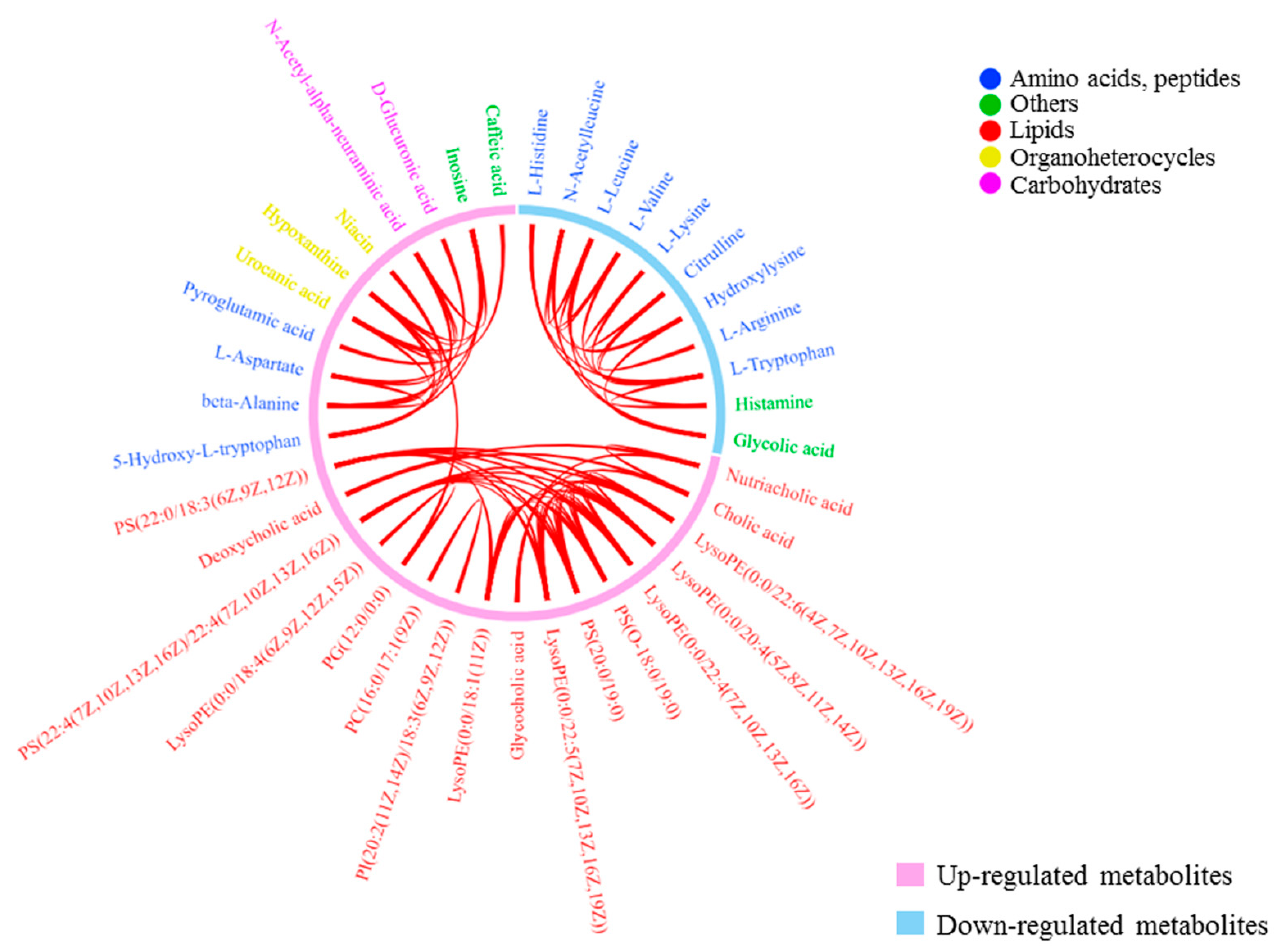
Figure 4. Chord diagram of the correlations between differential metabolites. When Pearson correla- tion coefficient between two metabolites is higher than 0.7 in absolute value, a connection is estab- lished. Colors denote the classification of metabolites. The pink circular arc represents up-regulated metabolites, and the blue circular arc represents down-regulated metabolites. More correlations between metabolites trend toward positive correlations. The most conspicuous correlations are lipid–lipid connections and amino acid-amino acid connections, revealing unique functional clusters of co-regulated metabolites including lyso-phosphatidylethanolamine, phosphatidylserine, bile acids, and amino acids.